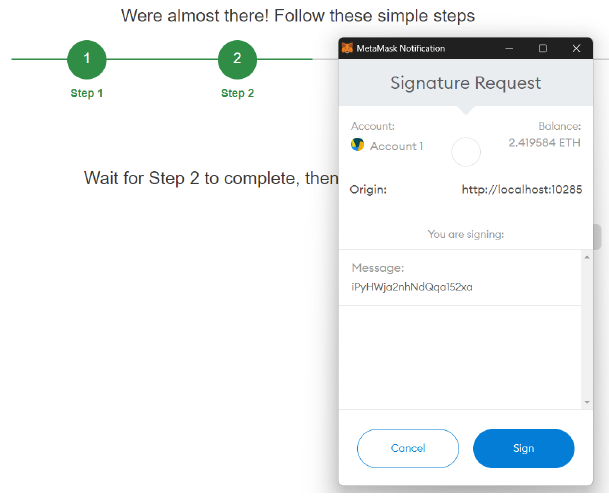
Figure 7. Signature of the LA challenge.